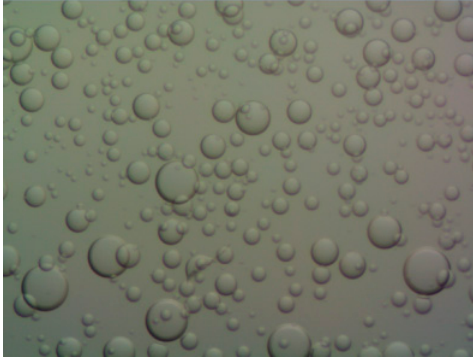
Figure 3. Droplet diameter distribution observed under high ‐ power microscope.